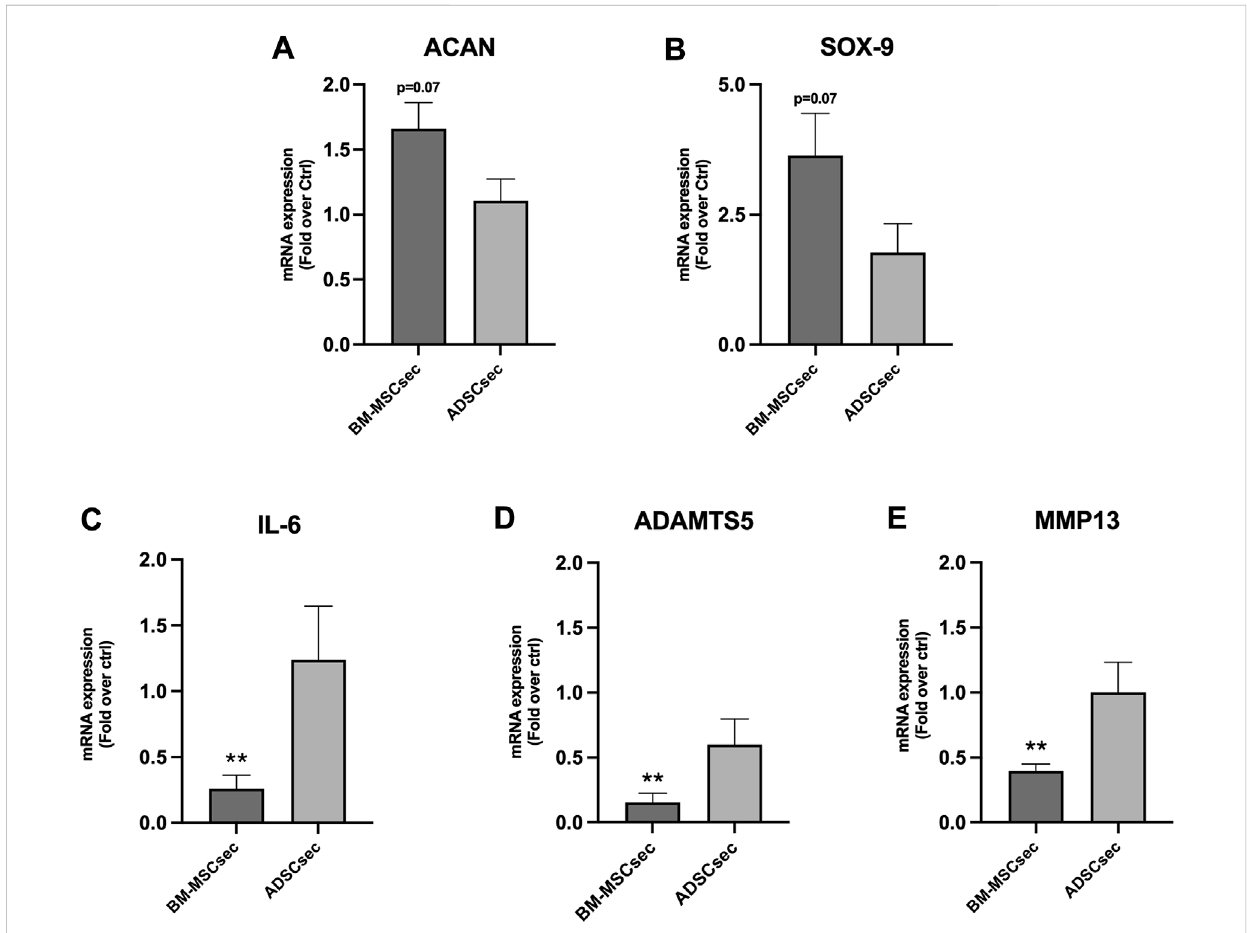
FIGURE 7 BM-MSCsec improved hNPC ECM and catabolic marker gene expression. hNPCs treated with BM-MSCsec demonstrated a higher expression of ACAN (A) and SOX9 (B) genes, while signi fi cantly reducing IL6 (C) , ADAMTS5 (D) and MMP13 (E) gene expression. Conversely, no signi fi cant differences were found in the group treated with ADSCsec. Results were normalized based on GAPDH expression and calculated as fold change compared to the controls. ** p <